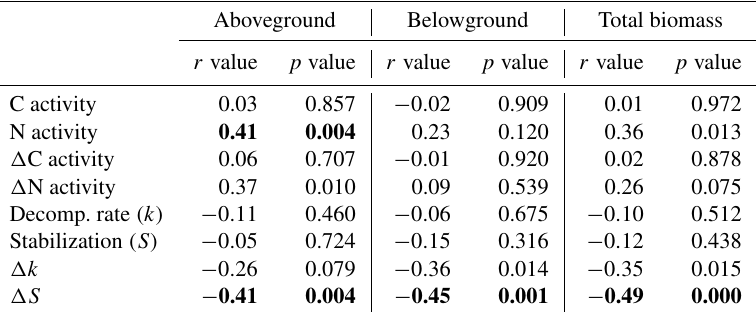
Table 2. Correlations between plant biomass parameters and soil microbial activity parameters using a Bonferroni correction for multi- ple comparisons ( α = 0 . 05/number of pairwise comparisons). Shown are Pearson correlation coefficients ( r ). Significant correlations are highlighted in bold ( p ≤ α ).